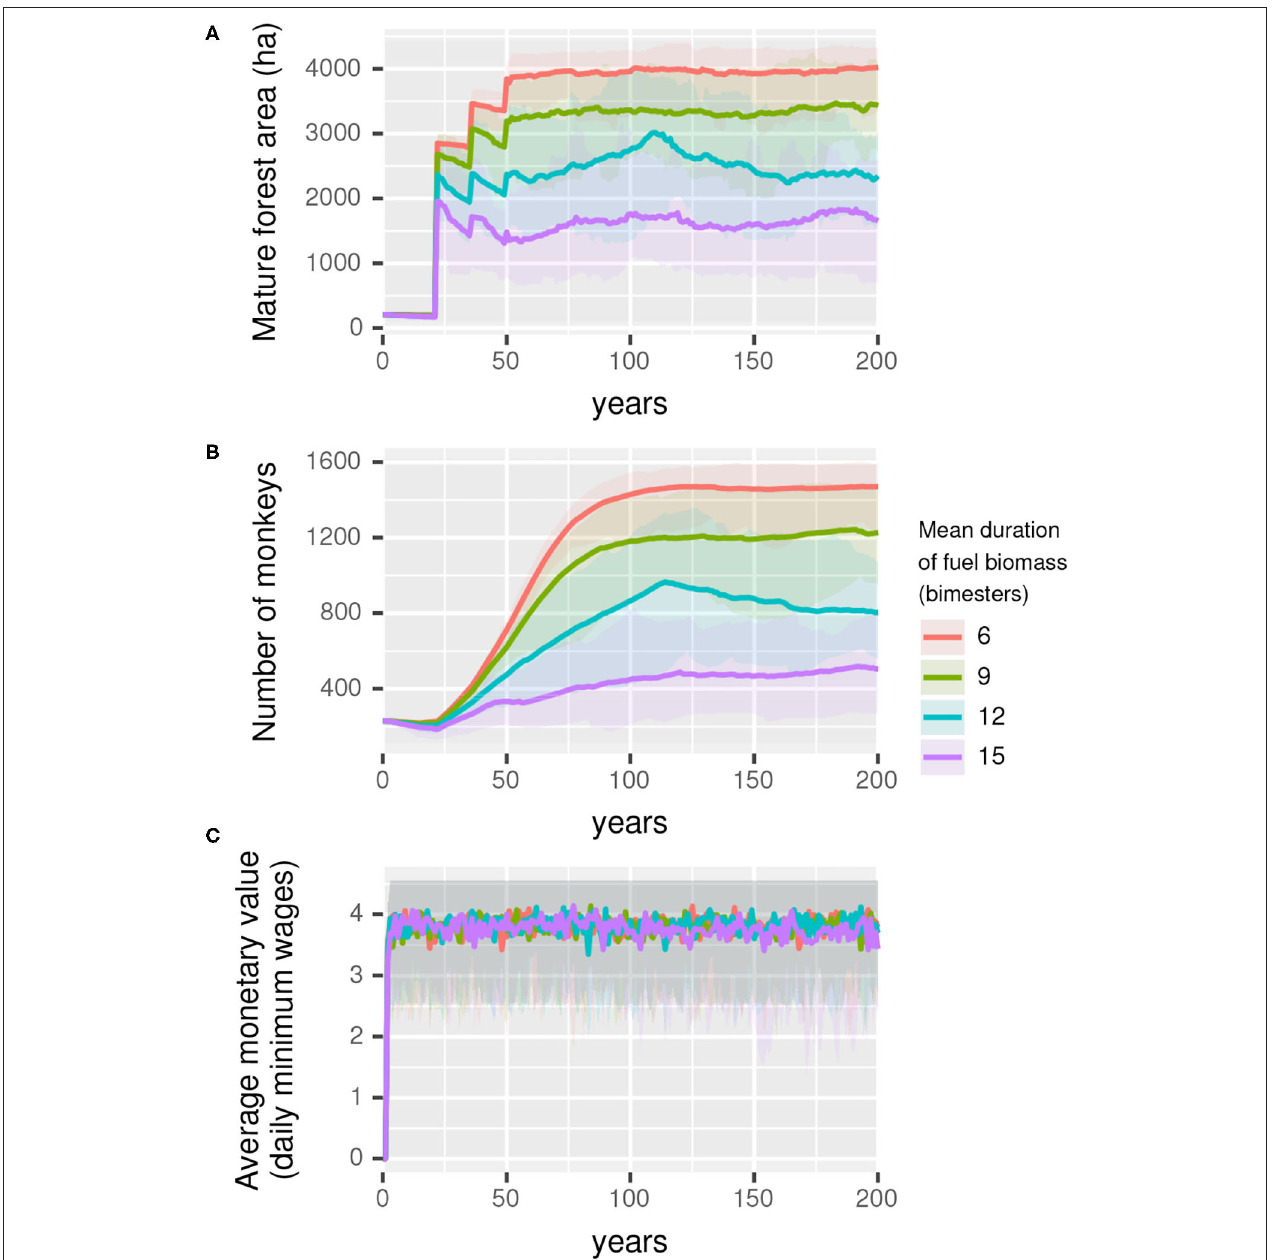
FIGURE 5 | Sensitivity analysis of the mean duration of fuel biomass (bimesters). Each panel represents the change in an output variable for a 200 years period and 30 simulation runs for each value of the mean duration of fuel biomass. (A) Mature forest area in ha (forest with successional age > 50 years). (B) Total number of monkeys. (C) Average monetary value of activities done by the households in daily minimum wages. Lines represent the mean and upper and lower shadows represent 5th and 95th quartiles, respectively, for each value of the mean duration of fuel biomass (different